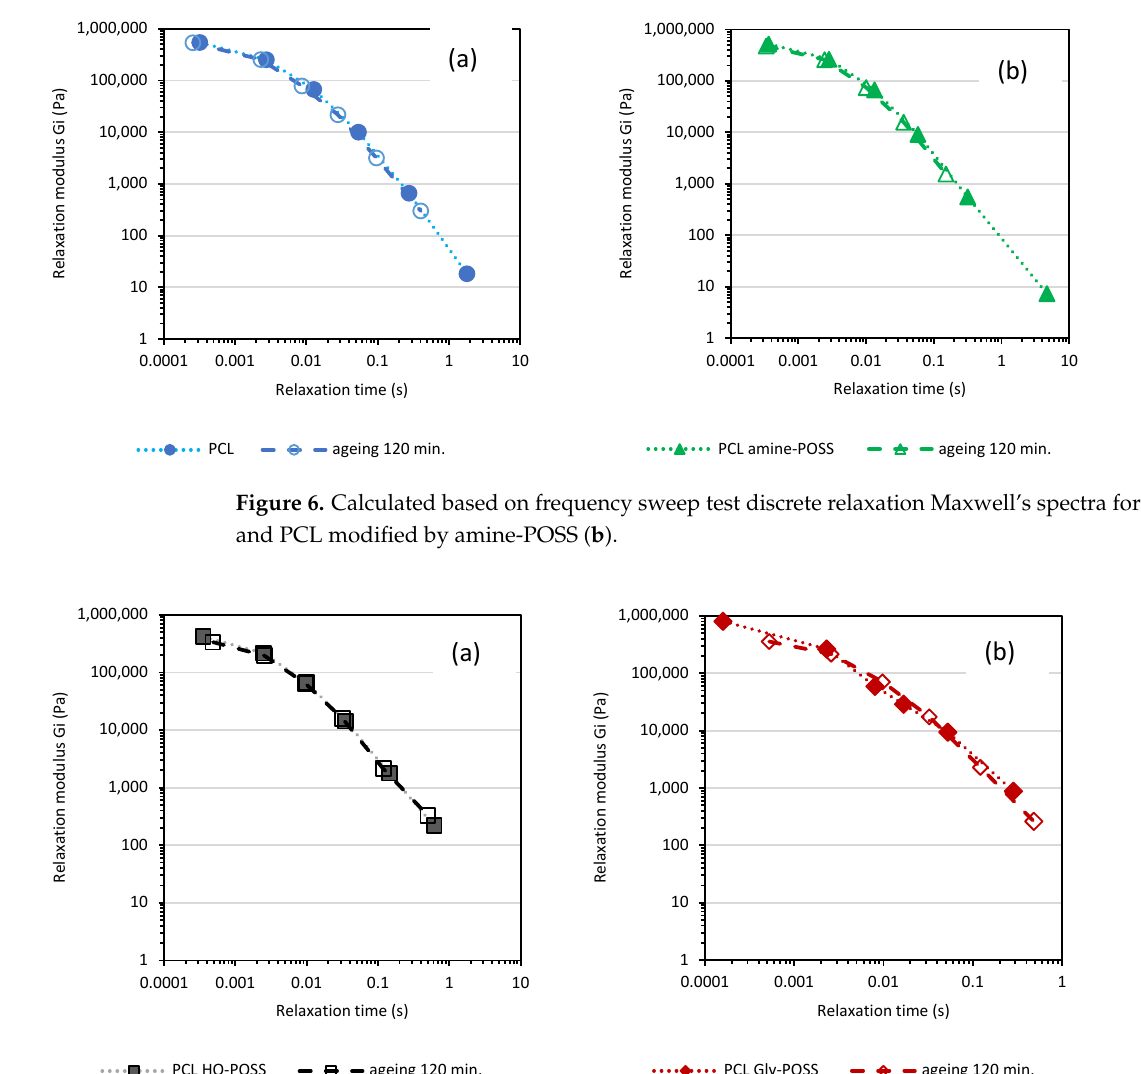
Tables S2–S5 (Supplementary Materials Tables S2–S5). Thermo-oxidative degradation over 120 min. at 100 ° C reduced the values of the relaxation times λ calculated for every Maxwell element for both PCL and PCL amine-POSS indicating the changes in the struc- element for both PCL and PCL amine-POSS indicating the changes in the structure of the ture of the melted PCL. melted PCL.